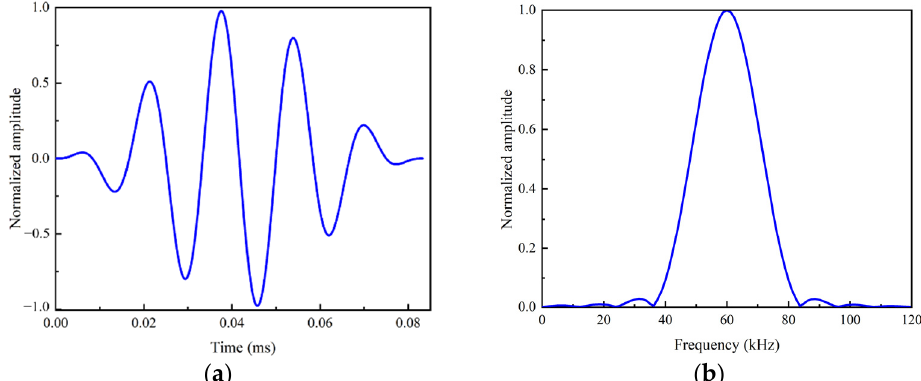
Figure 5. Excitation signal with central frequency of 60 kHz. ( a ) Excitation signal in time domain. ( b ) Excitation signal in frequency domain